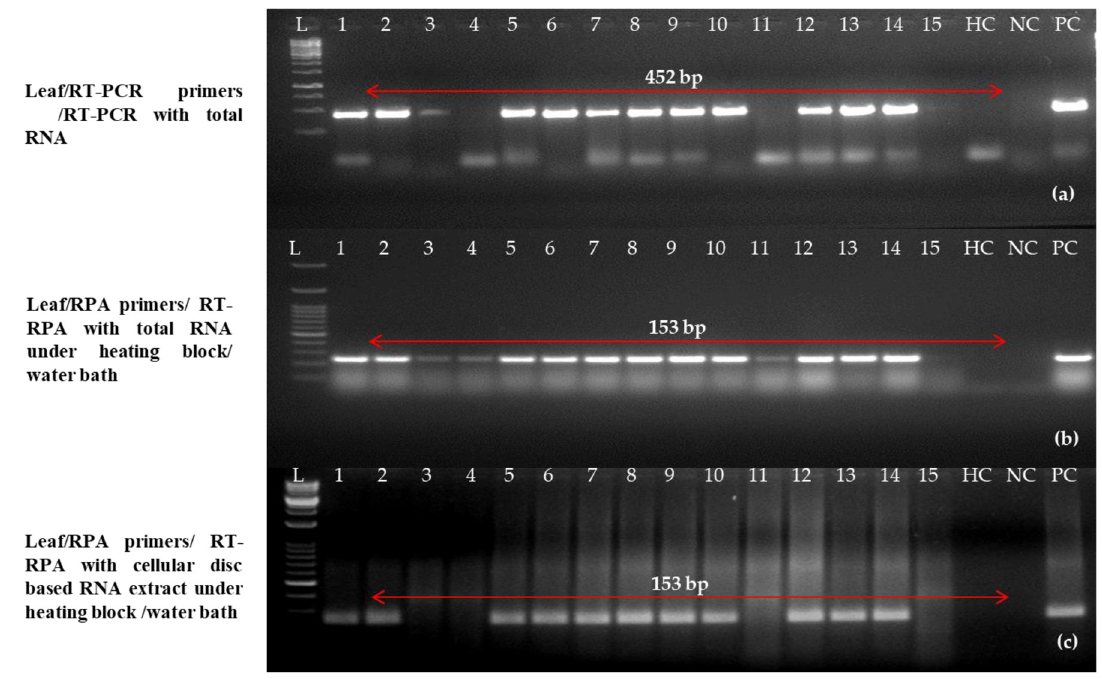
Figure 8. Validation of reverse-transcription recombinase polymerase amplification (RT-RPA) and reverse transcription-polymerase chain reaction (RT-PCR) in one step for potato leafroll virus (PLRV) detection (leaves). ( a ) One-step RT-PCR performed with previously reported primers [12] on purified RNA; ( b ) one-step RT-RPA with newly optimized primer LRRPAF3/R3 on purified total RNA; ( c )